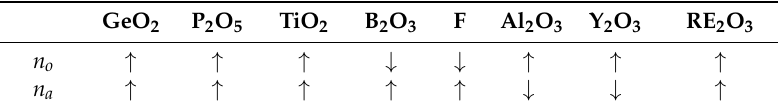
Table 1. The effect of some common dopants on the optical and acoustic index of silica. RE stands for rare earth. The arrows represent, in the obvious way, an increase or decrease in a material value when added to